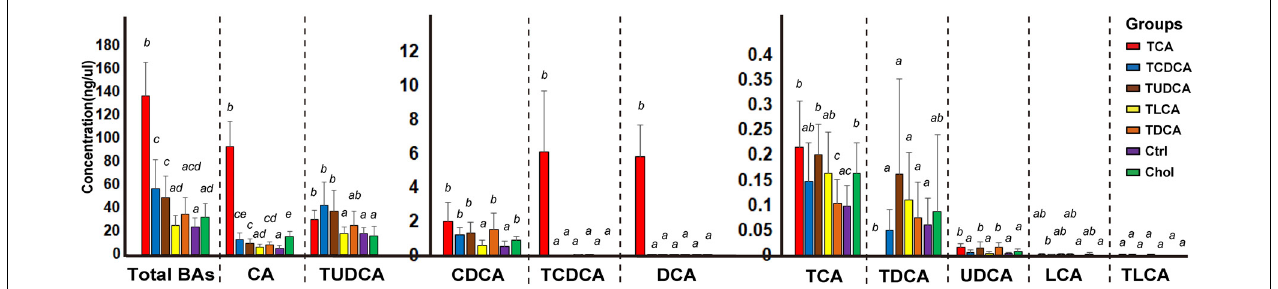
FIGURE 1 | Concentrations of different biliary BAs in the galls of different groups. For the TCA, TCDCA, and Ctrl groups, n = 8; for the TUDCA, TLCA, TDCA, and Chol groups, n = 9. Different letters above bars indicate statistically significant ( P < 0.05) in each BA ( x -axis). Groups not sharing the same lowercase letter are significantly different ( P <